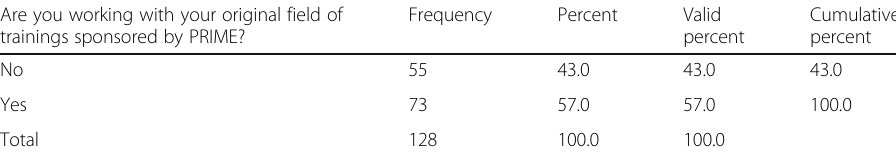
Table 9 Original field of training provided to trainees and their current employment situations Are you working with your original field of trainings sponsored by PRIME?